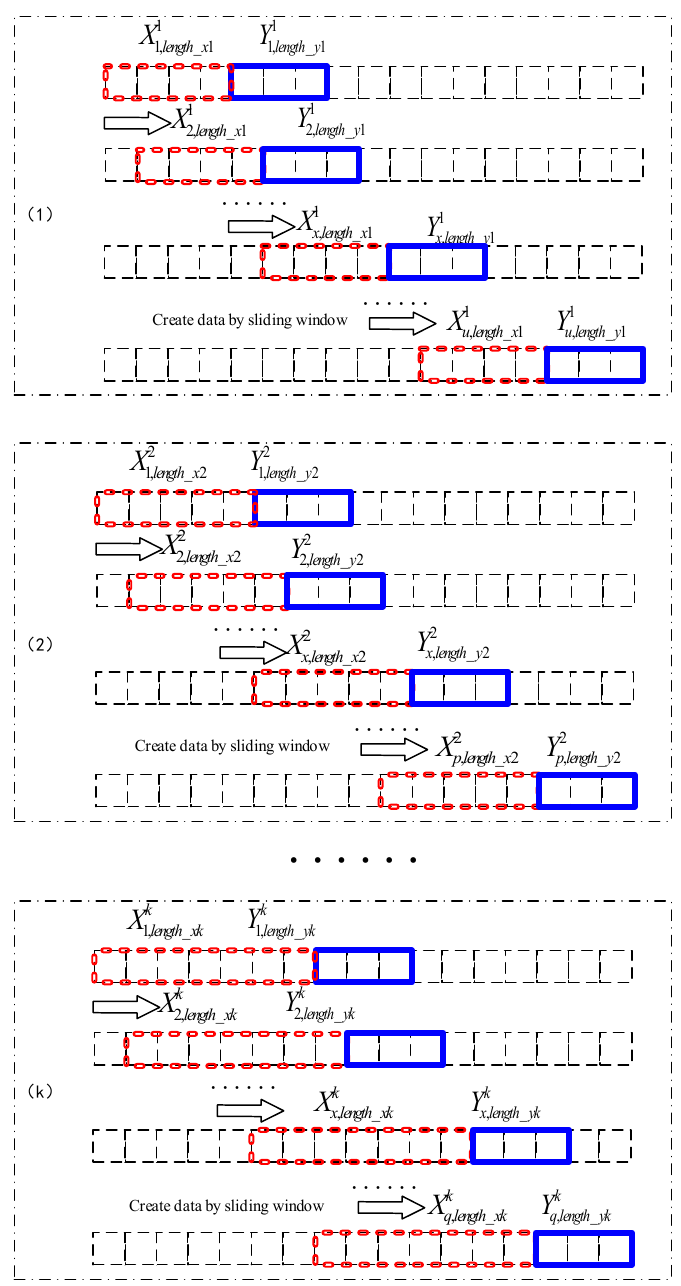
k Figure 4. Constructing data with sliding windows of different scales. Figure 4. Constructing data with k sliding windows of different Figure 4 is a schematic diagram of K sliding windows of different scales. It can be seen that the sizes of the red sliding windows are different at different scales, and the sizes of the blue sliding windows are the same.